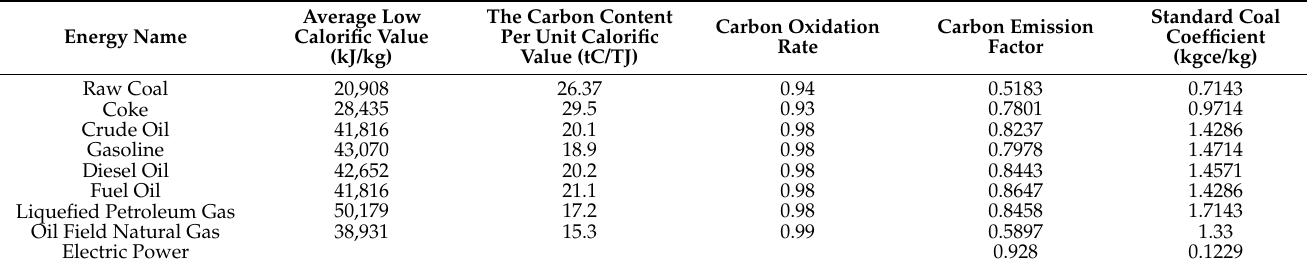
Table 1. Energy carbon emission coefficient and converted standard coal coefficient.